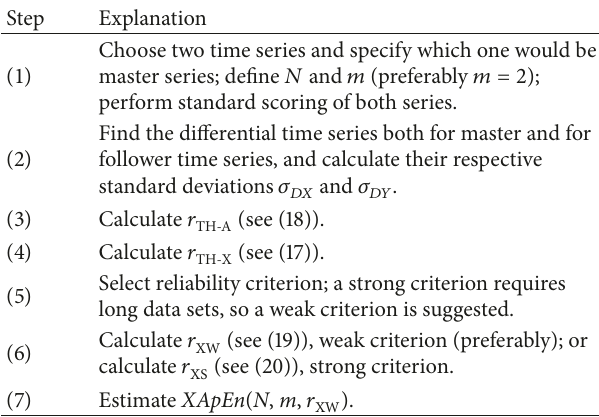
Table 6: Steps for reliable XApEn